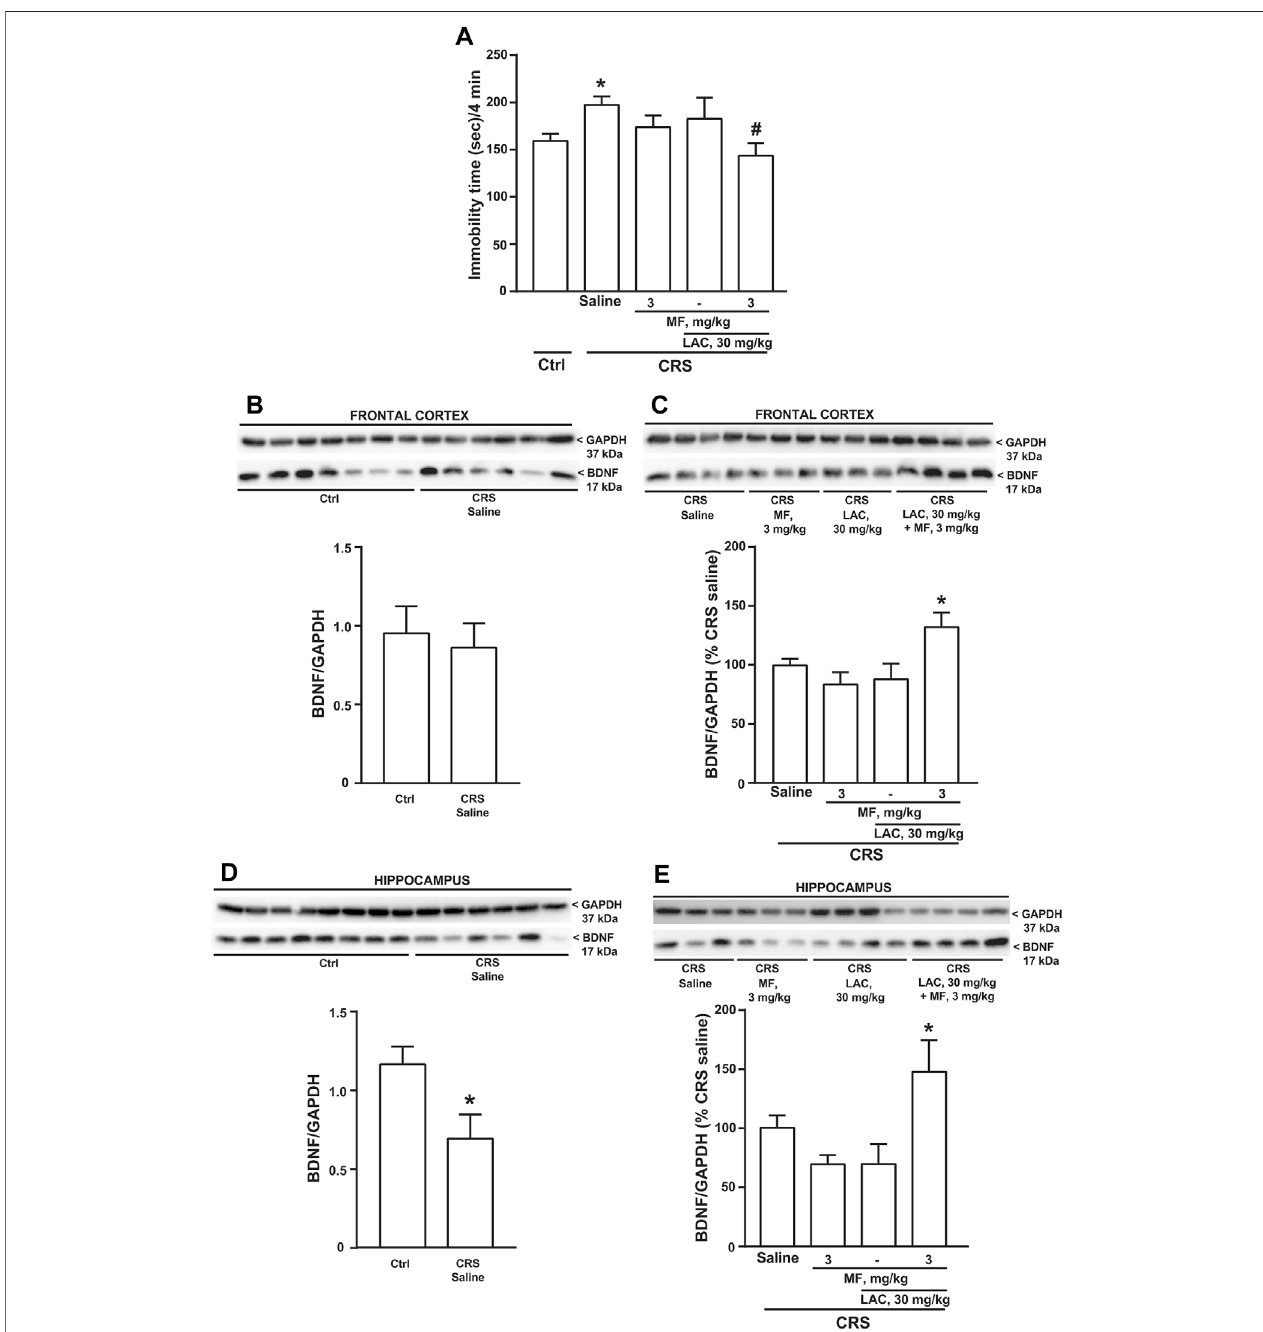
FIGURE 3 | Synergism between MF and sub-threshold doses of LAC in reducing the immobility time and enhancing BDNF expression in mice subjected to CRS. Immobility time in the forced swim test in unstressed control (Ctrl) mice and in mice exposed to CRS for 21 days, after 14 days of treatment with saline, MF (3 mg/kg), LAC 30 (mg/kg) or their combination is shown in (A) . BDNF protein levels in the frontal cortex ad hippocampus are shown in (B,C,D,E) , respectively. In (C,E) , immunoblots are representative of two blots used for the analysis. Data are means ± SEM ( n = 8 – 15 in A; 6 – 7 in B; and 6 – 8 in (C – E) . One-way ANOVA + Fisher ’ s LSD (A) , p < 0.05 vs. saline (*) or vs. CRS saline (#), F (4,41) = 2.420; p = 0.0637 (C) , * p < 0.05 vs. all other groups, F (3,24) = 4.504; p = 0.0121, and (E) , F (3,24) = 4.171; p = 0.0164. Student ’ s t test (D) t 12 = 2.551; p = 0.0254.